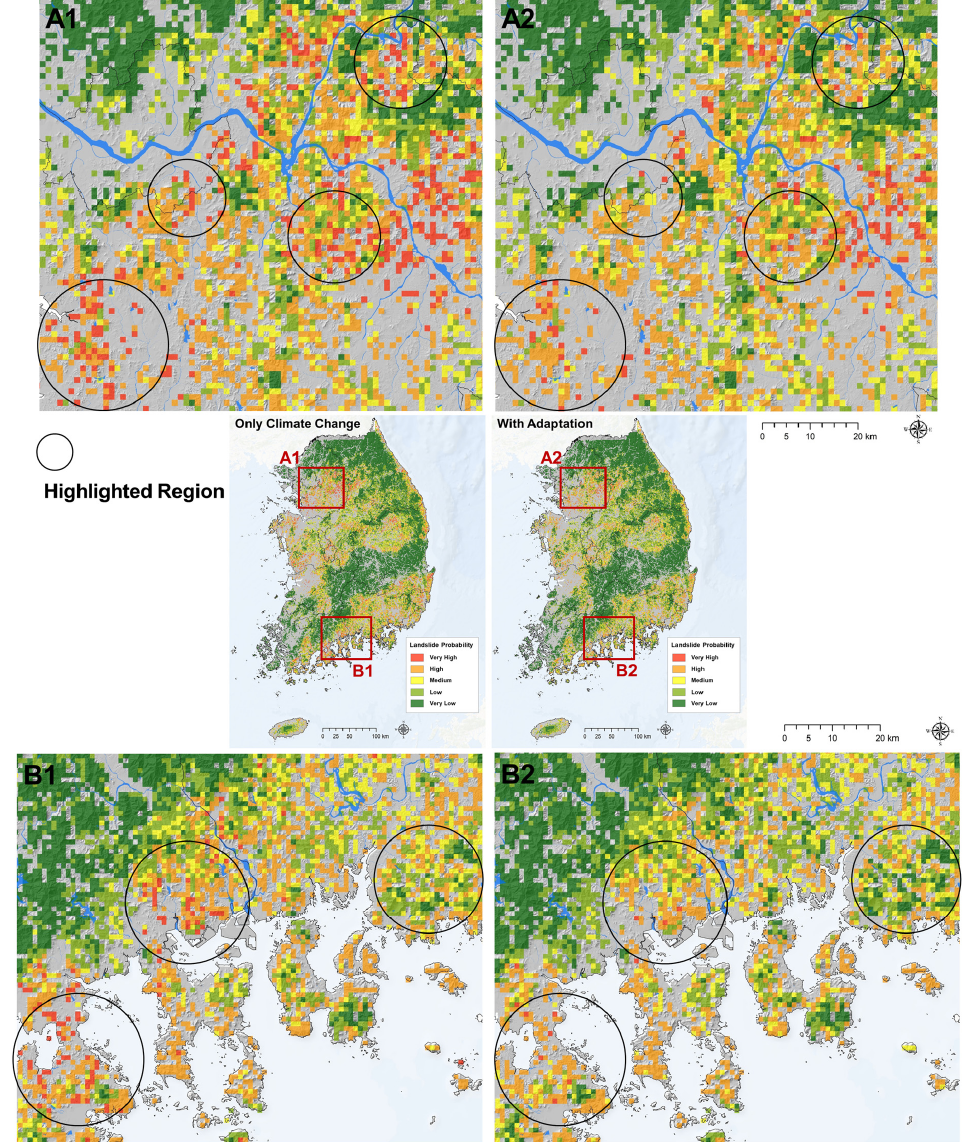
Figure 8. Close-up image of the highlighted region for comparing adaptation in 2092: ( A1 ) only climate change applied in Seoul metropolitan region; ( A2 ) applied with adaptation in Seoul metropolitan region; ( B1 ) applied only climate change in the southern coastal region; ( B2 ) applied with adaptation in the southern coastal region.